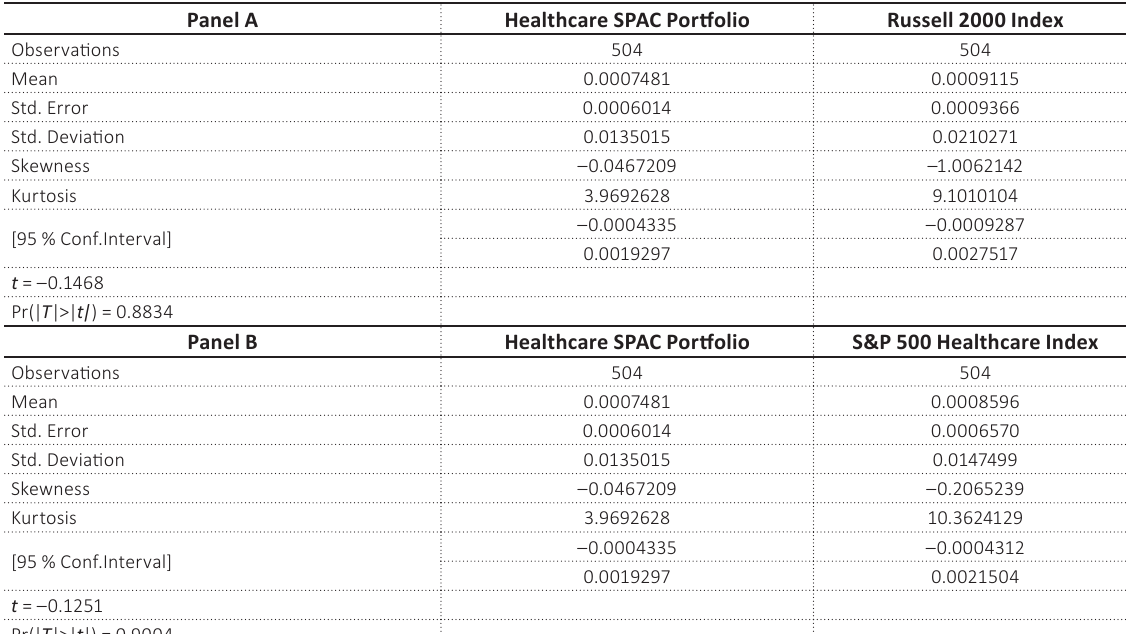
Table 3. T -tests